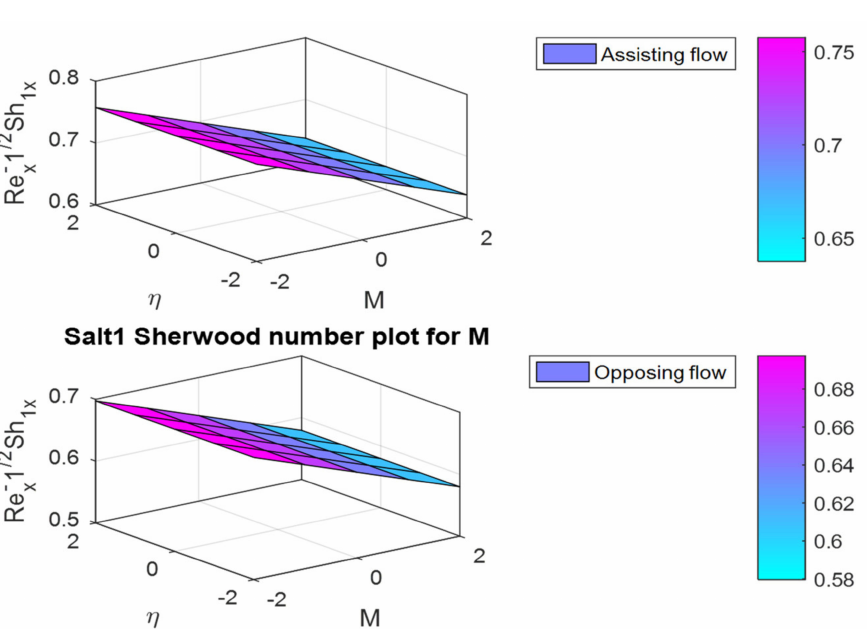
Figure 27. Surface plots of the φ (cid:48) ( 0 ) for different values of M . The skin friction coefficient θ (cid:48) ( 0 ) and φ (cid:48) ( 0 ) plots for different Pr values are shown in (cid:48)(cid:48) ( Figures 28–30. As Pr grows, f 0 ) increases in assisting flow and falls in opposing